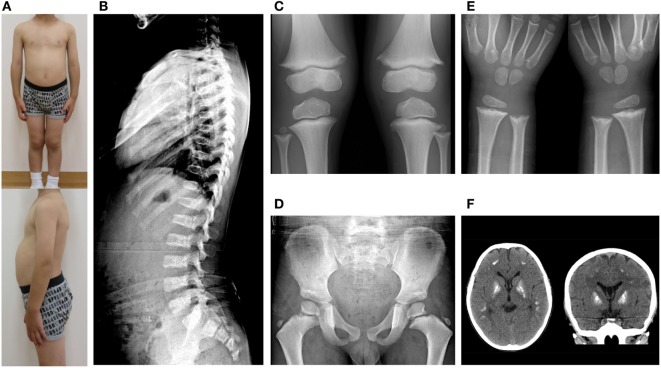
(A) Clinical photographs. (B) Spinal radiograph showing generalized platyspondyly with irregular endplates and irregular ossifications in the posterior vertebral bodies. (C) Radiograph of the knees showing irregular and sclerotic splayed metaphyses of the distal femur, proximal tibia, and fibula. (D,E) Radiograph of the hip and wrist showing similar metaphyseal changes as the knee. (F) Brain CT showing bilateral calcification of the basal ganglia.